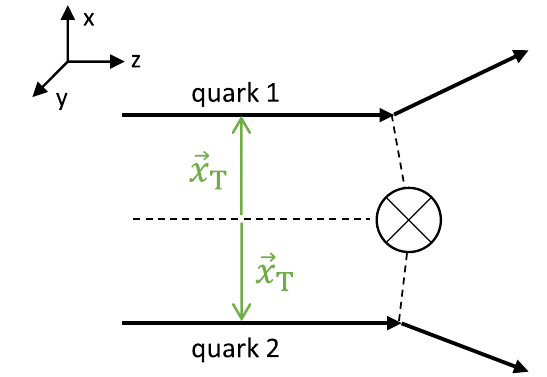
Fig. 2 Cartoon for the static potential scattering process